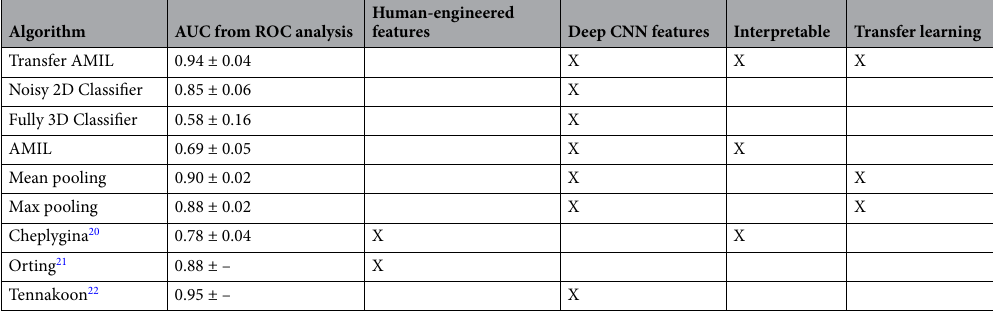
Table 2. Performance